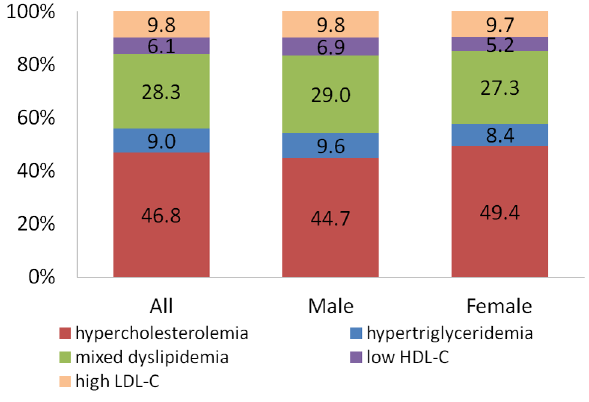
Figure 1. The proportion of patients with individual or mixed lipid